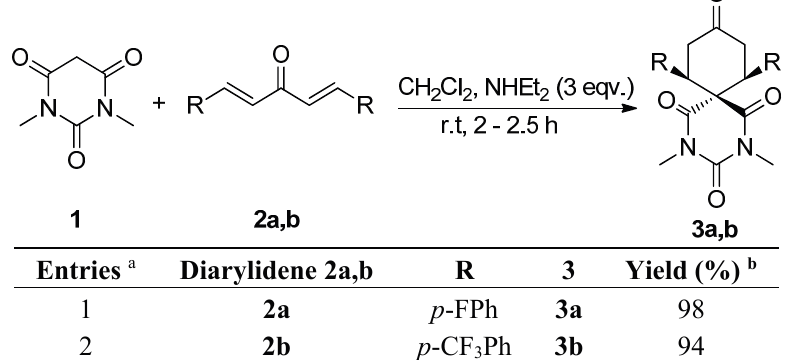
Table 1. Cascade [5+1] double Michael addition reaction as key step to form spirocyclic products 3a , b